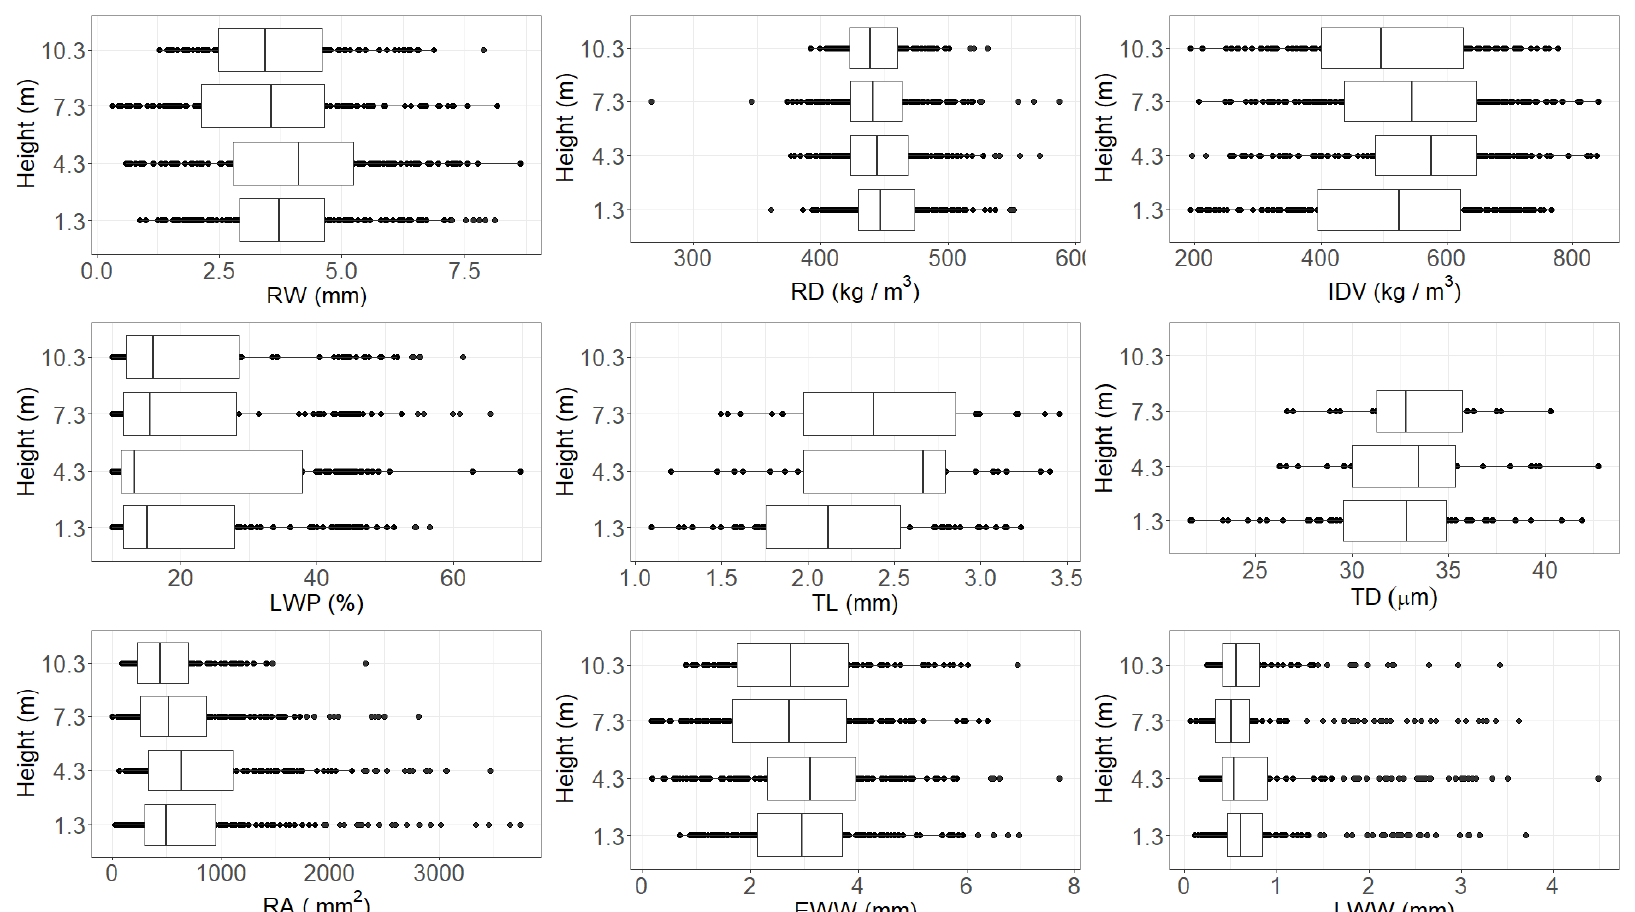
Figure 3. Intra-ring longitudinal variation of wood quality attributes of white spruce at different heights up the stem. The plots depict the interquartile range (the ‘box’) and individual data points in the first and fourth quartiles, including the minimum and the maximum values (the ‘whiskers’). The wood quality attributes are: RW: ring width, RD: ring density, IDV: intra-ring density variation, LWP: latewood proportion, TL: tracheid length, TD: tracheid diameter, RA = ring area, EWW = earlywood width, and LWW = latewood width.